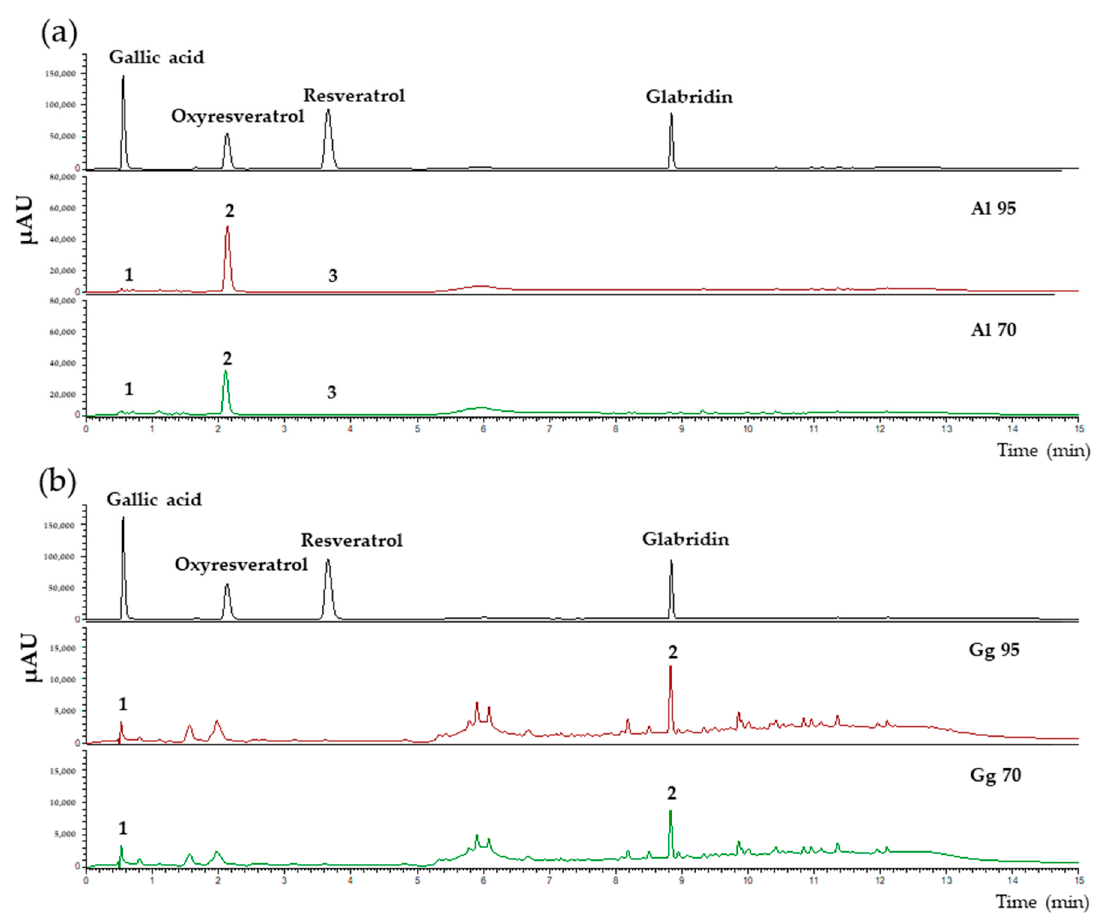
Figure 1. Chromatograms of A. lakoocha (Al) and G. glabra (Gg) extracts using 70% and 95% ethanol. Ultra High Performance Liquid Chromatography (UHPLC) analysis with detection at a wavelength of 280 nm. ( a ) Standards (gallic acid, oxyresveratrol, resveratrol and glabridin) and the chromatograms from Al70 and Al95 extracts show gallic acid (1), oxyresveratrol (2) and resveratrol (3); ( b ) standards (gallic acid, oxyresveratrol, resveratrol and glabridin) and the chromatograms of Gg70 and Gg95 extracts showing gallic acid (1) and glabridin (2). Table 1. Total phenolic and flavonoid content, antioxidant activity, and mushroom tyrosinase